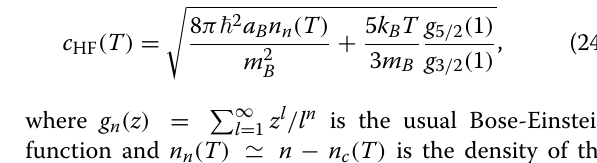
Fig. 7 First and second sound velocities in an interacting molecular Bose gas with gas parameter n B a 3 blue dashed and red dotted lines show c HF ( T ) and c B ( T ) ; while in b , they are respectively the approximate velocities c 1 = v S and c 2 = v / The two inset show the LP ratio (cid:8) LP (red dashed line) and the weight ratio W 2 / W 1 (black solid line). Adapted from Ref.